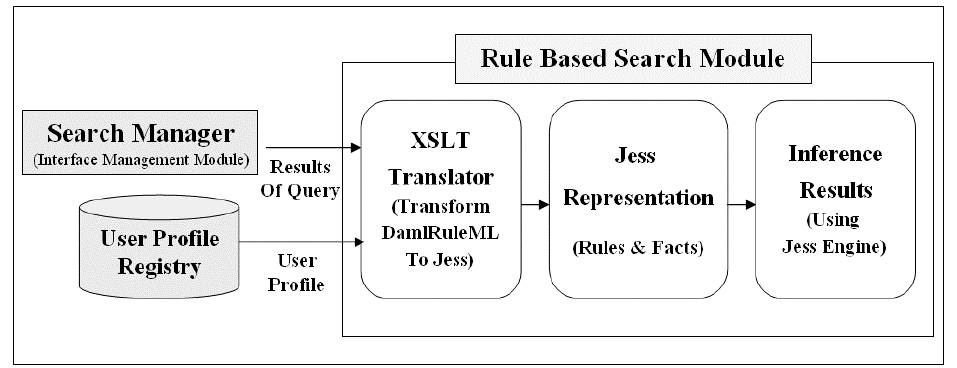
Figure 5. System Architecture of Rule Based Search